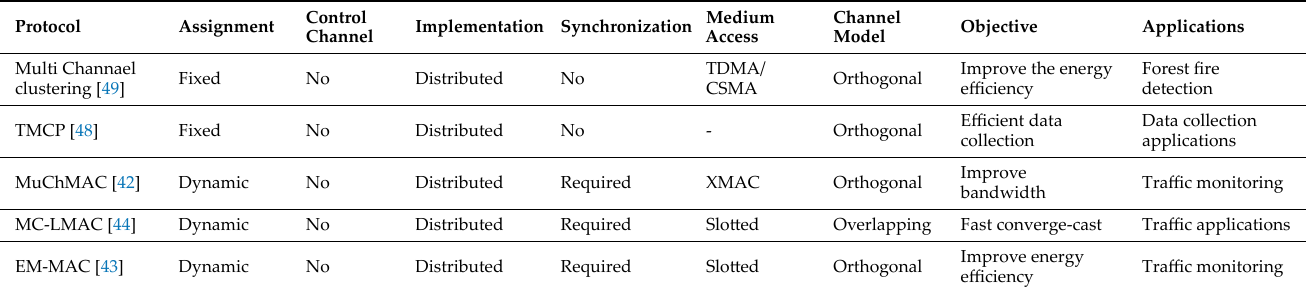
Table 3. The comparison of various channel assignment methods.